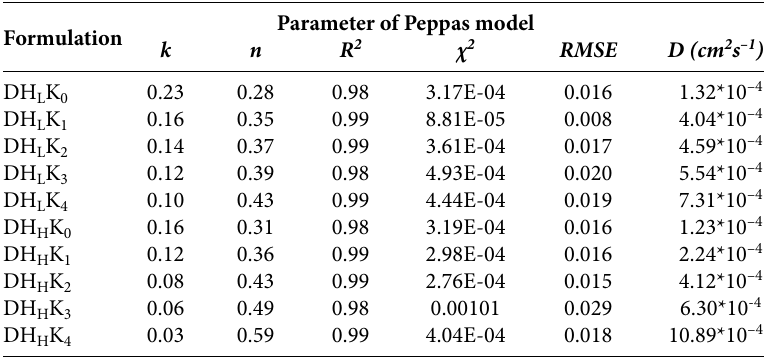
Table 2. Estimated swelling parameters of the film as per Peppas model and the diffusion coefficient of water.